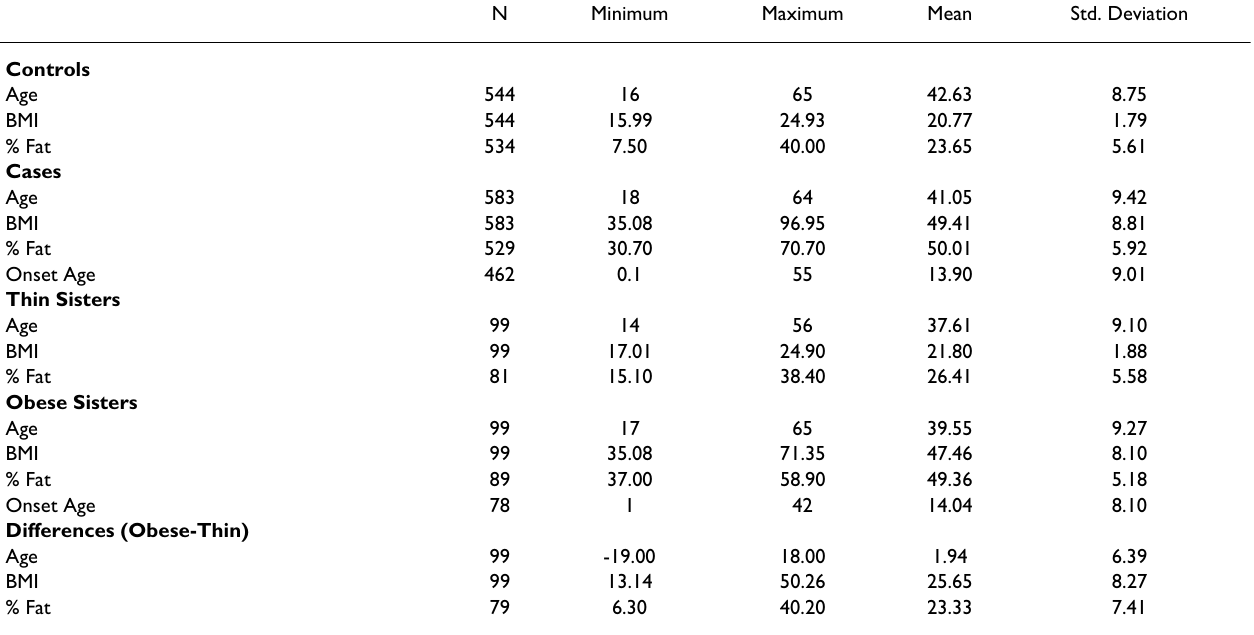
Table 1: Clinical characteristics of cases/controls and discordant sister pairs